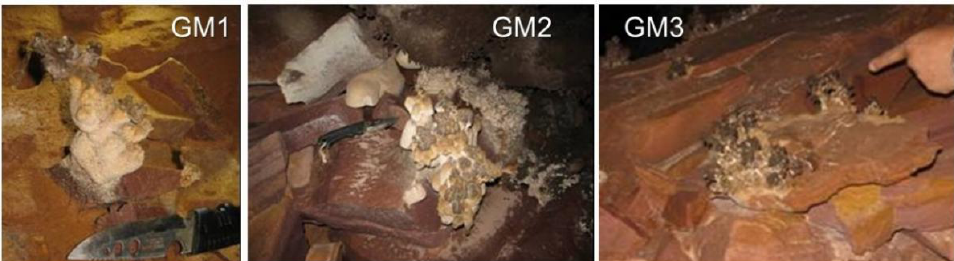
Figure 2. Morphological appearances of the speleothem samples. GM1: speleothem shows a mor- phology similar to “champignons”. GM2 and GM3: speleothems show coral-like morphology. The lengths of the knife blade and handle in the left and middle photos were 9 cm and 12 cm, respec- tively.